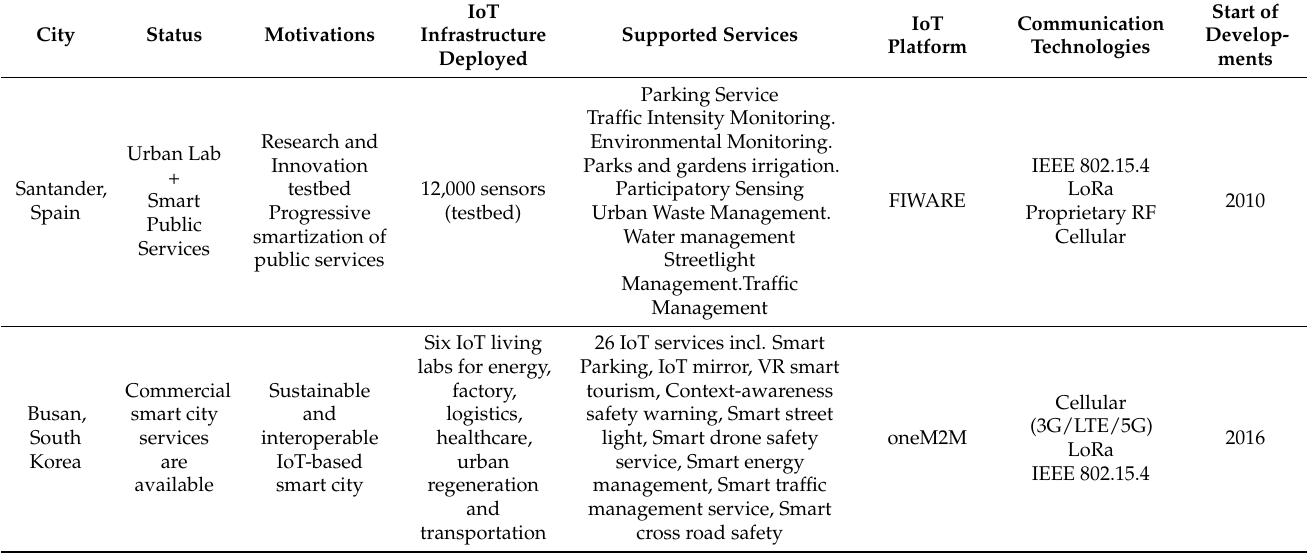
Table 1. Summary of features from analysed cities.3. Key Technologies